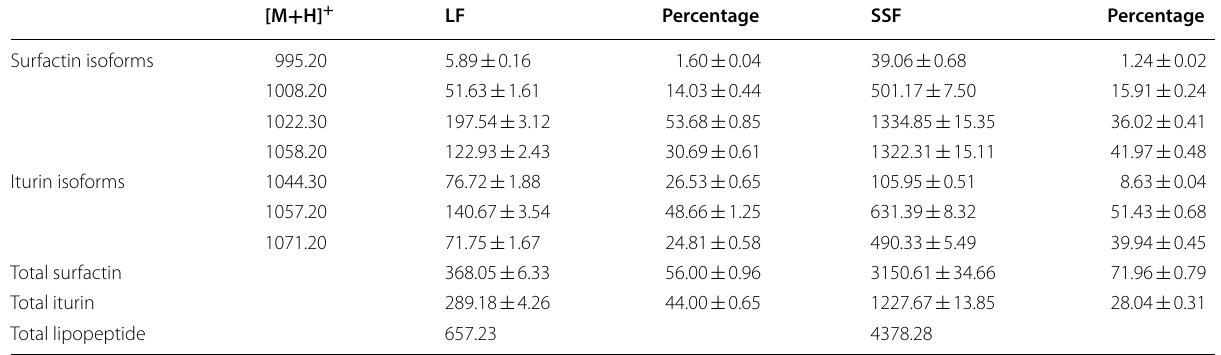
Table 1 Effect of different culture media on lipopeptide production